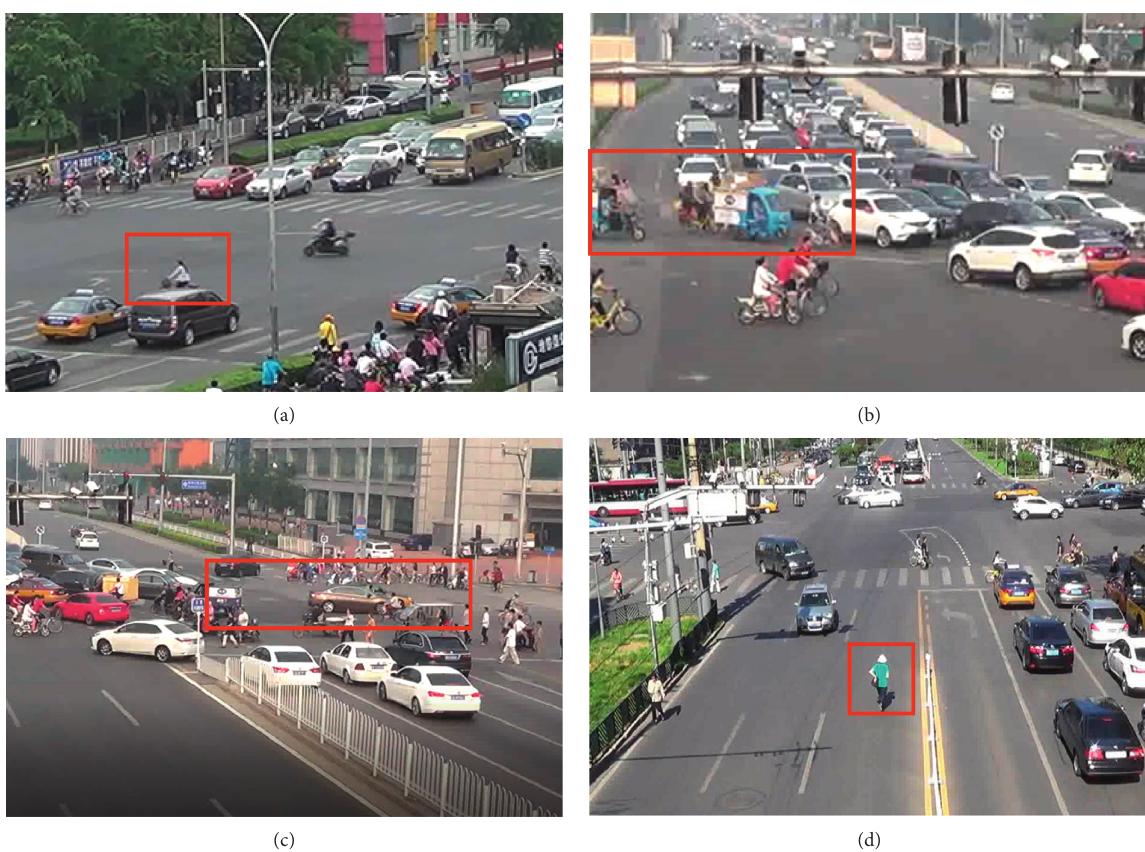
Figure 1: Violations at signalized intersections under mixed-traffic in Beijing. (a) Running red light at the through phase. (b) Running red light at the left-turn phase. (c) Crossing the intersection diagonally. (d) Intruding into the